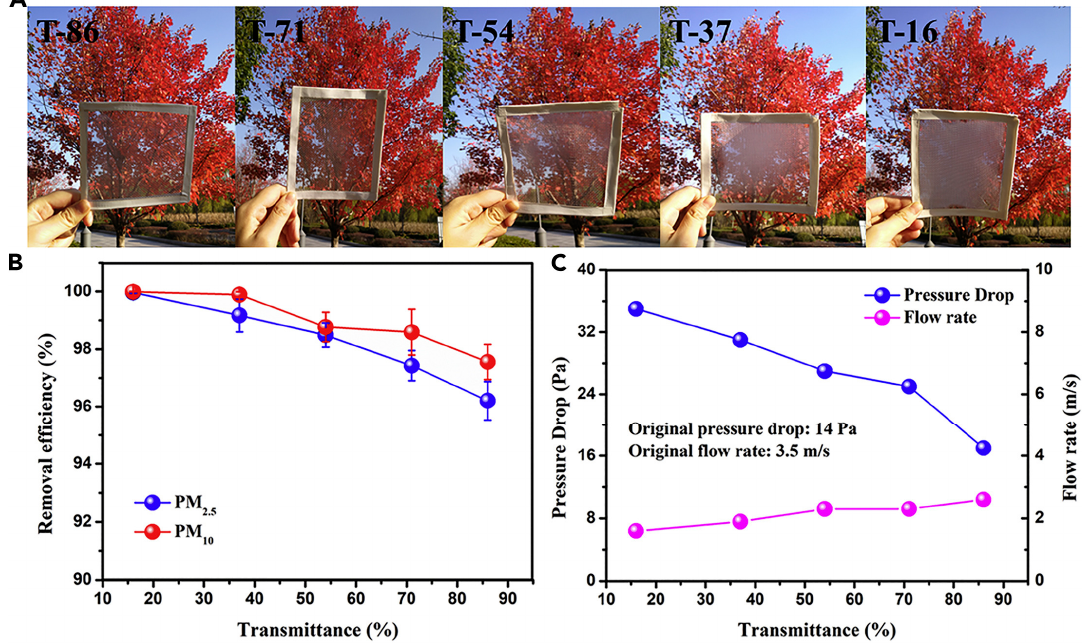
Figure 3. ( A ) Photographs of PDMS/PMMA-chitosan transparent air filters at different transparencies; ( B ) PM 2.5 and PM 10 removal efficiency; and ( C ) pressure drop and flow rate of transparent filters at di ff erent transmi tt ances. From [74], copyright (2019), originally published under a CC-BY license.